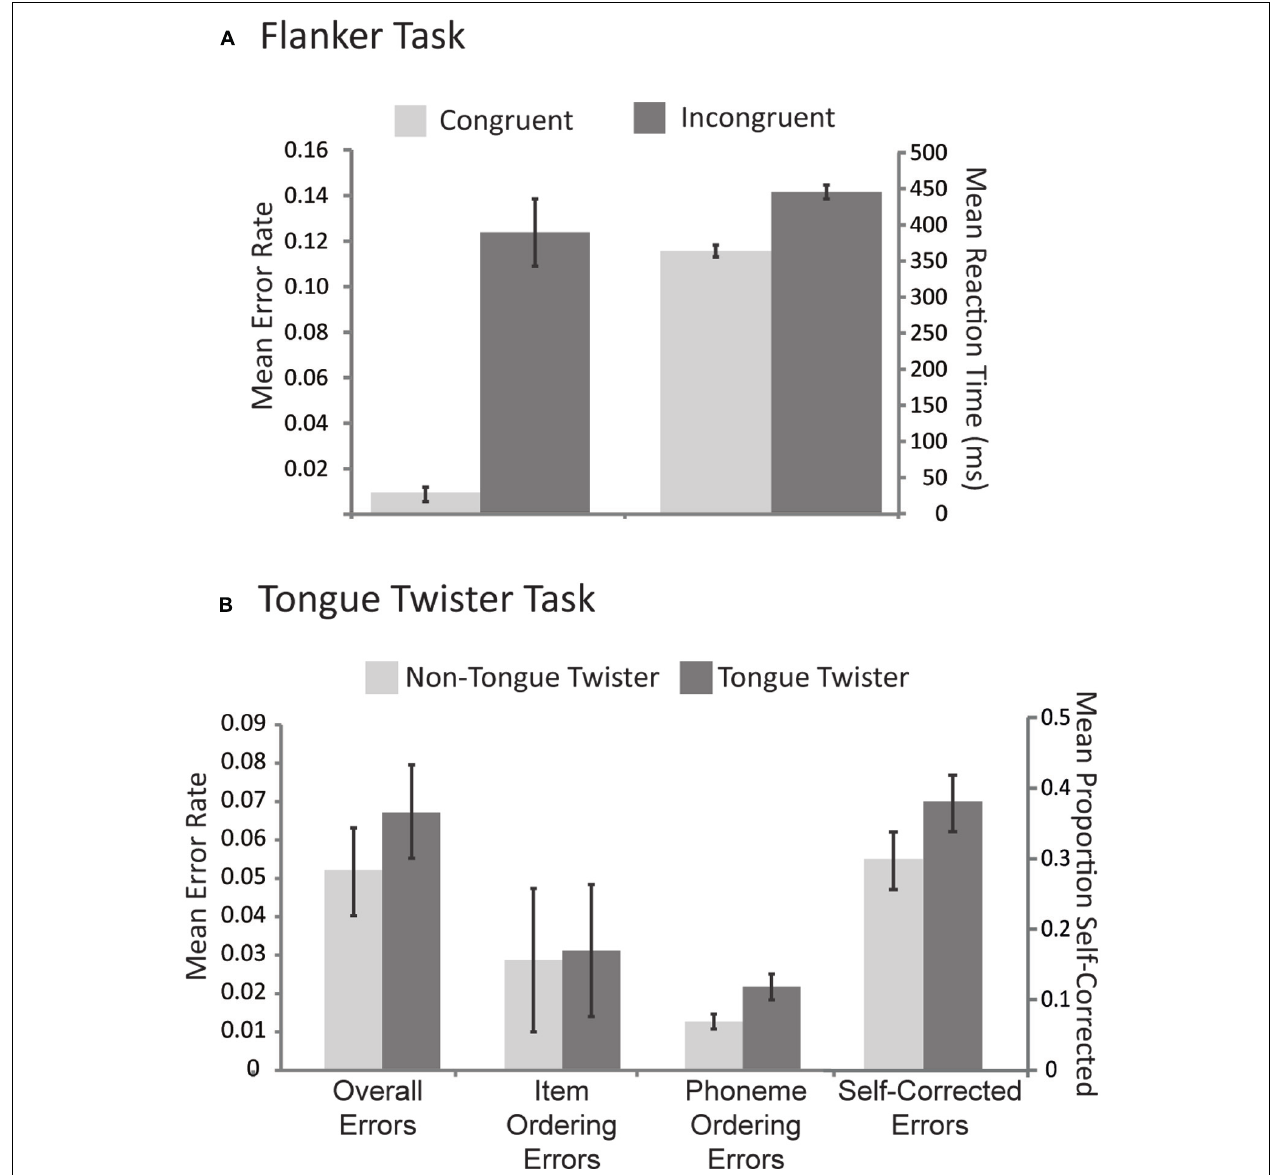
FIGURE 1 | Behavioral results across both tasks. (A) Mean error rates and reaction times for congruent and incongruent trials in the flanker task. (B) Mean error rates for three different types of errors in the tongue twister task as well as the proportion of errors that were self-corrected across each tongue twister condition. Error bars correspond to standard error across